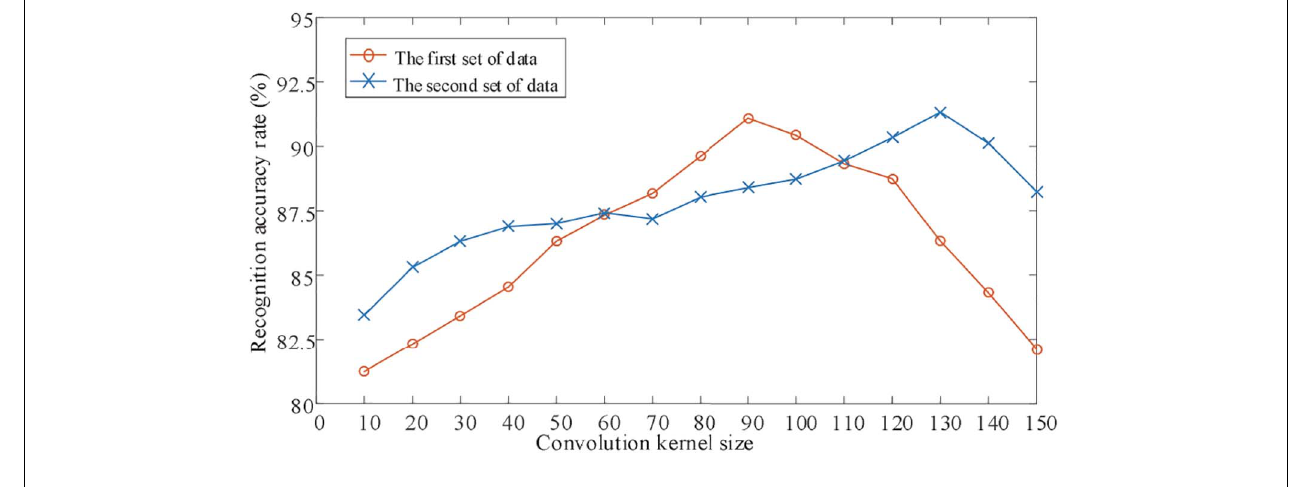
FIGURE 5 | Influence of convolution check on identification